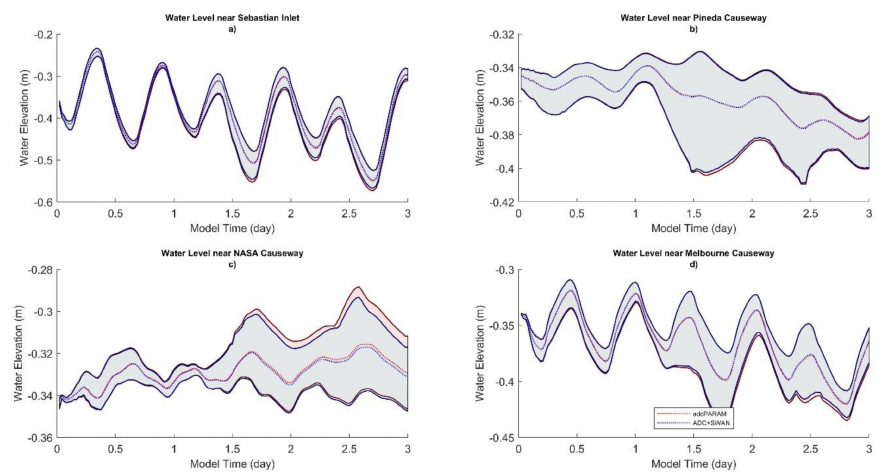
Figure 11. Time series plots of ADCparam and ADCIRC + SWAN ensemble ranges for water elevation (meters) with geoid offset near ( a ) Sebastian Inlet, ( b ) Pineda Causeway, ( c ) NASA Causeway, and ( d ) Melbourne Causeway. Each of these locations was selected based on location in the domain and associated fetches (station locations are specified in Figure 8). Dotted lines represent the average solution across the full ensemble, while upper and lower bounds of shaded areas represent the maximum and minimum values of the whole ensemble.